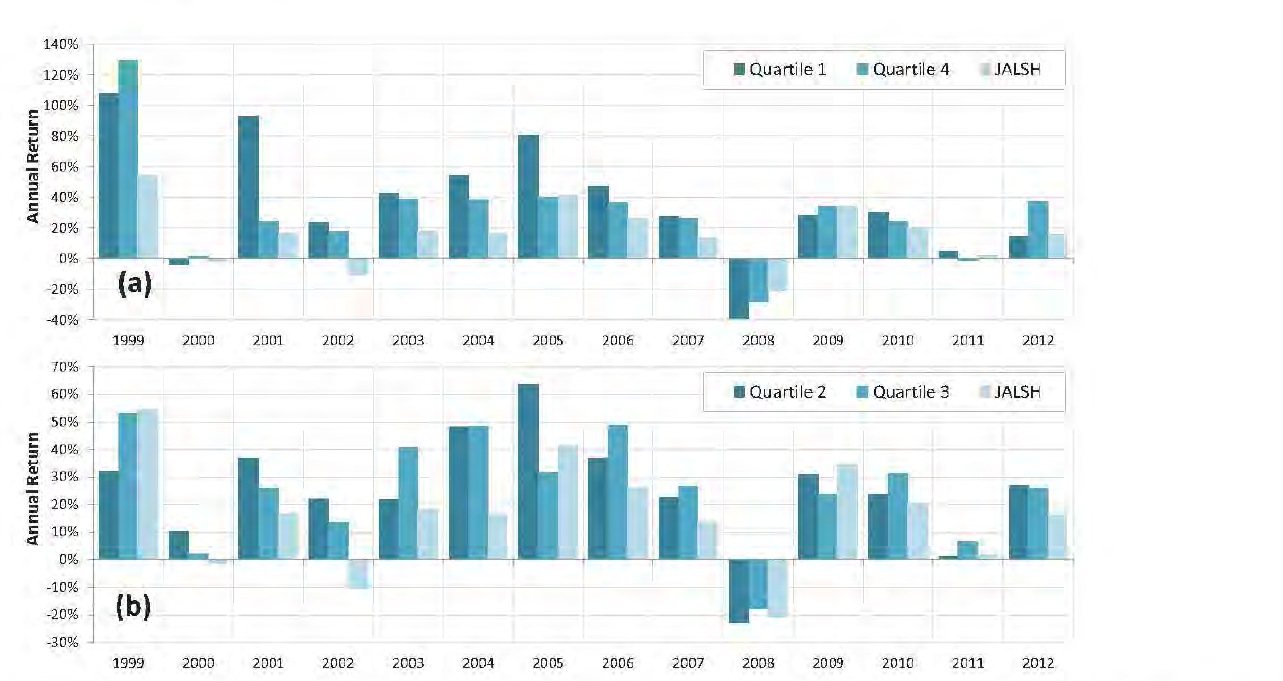
Figure 3: Portfolio and JALSH returns by year for value and growth stocks based on P/CF, 1999-2012 for (a) quartiles 1 and 4 and (b) quartiles 2 and 3 The data obtained from the portfolios formed by DY, see Table 4, showed that growth portfolios